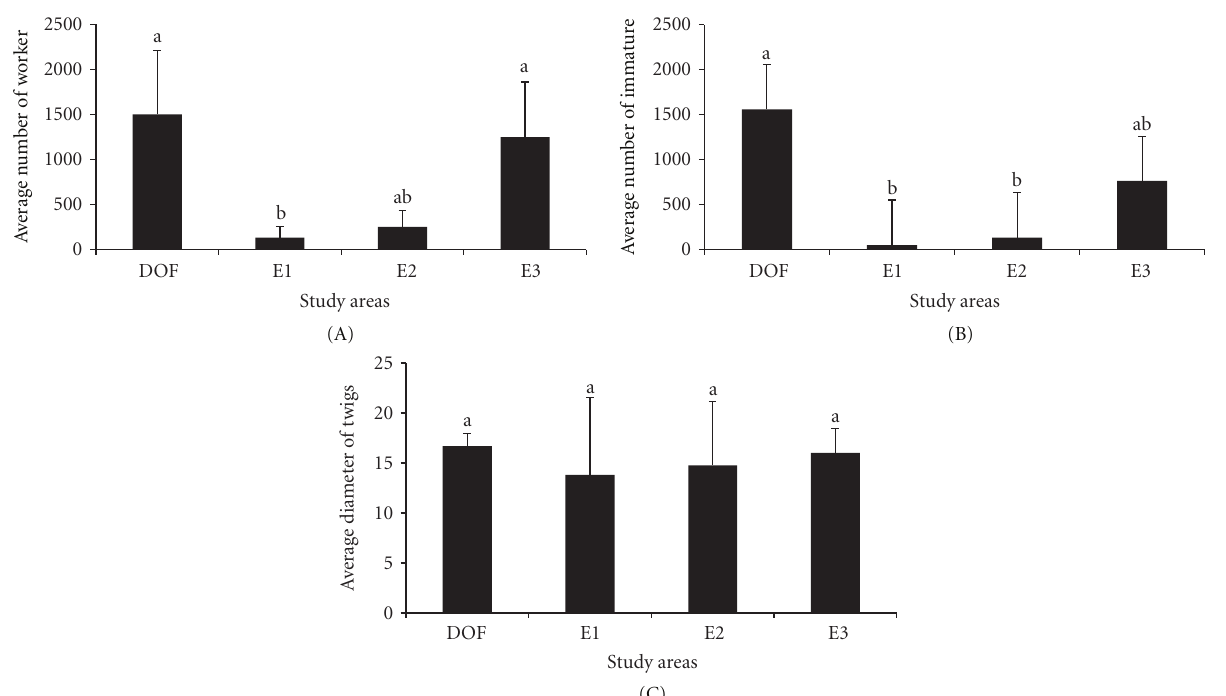
Figure 4: Average number of worker (A), immature stages (B), and the mean diameter of the twigs (C) containing ant colonies in each forest type. DOF: dense ombrophilous forest, E1: commercial plantation managed for 7 years, E2: commercial plantation managed for 28 years, and E3: eucalyptus plantation left unmanaged for 28 years. Vertical bar: standard deviation. Di ff erent letters: P < 0 . 05.